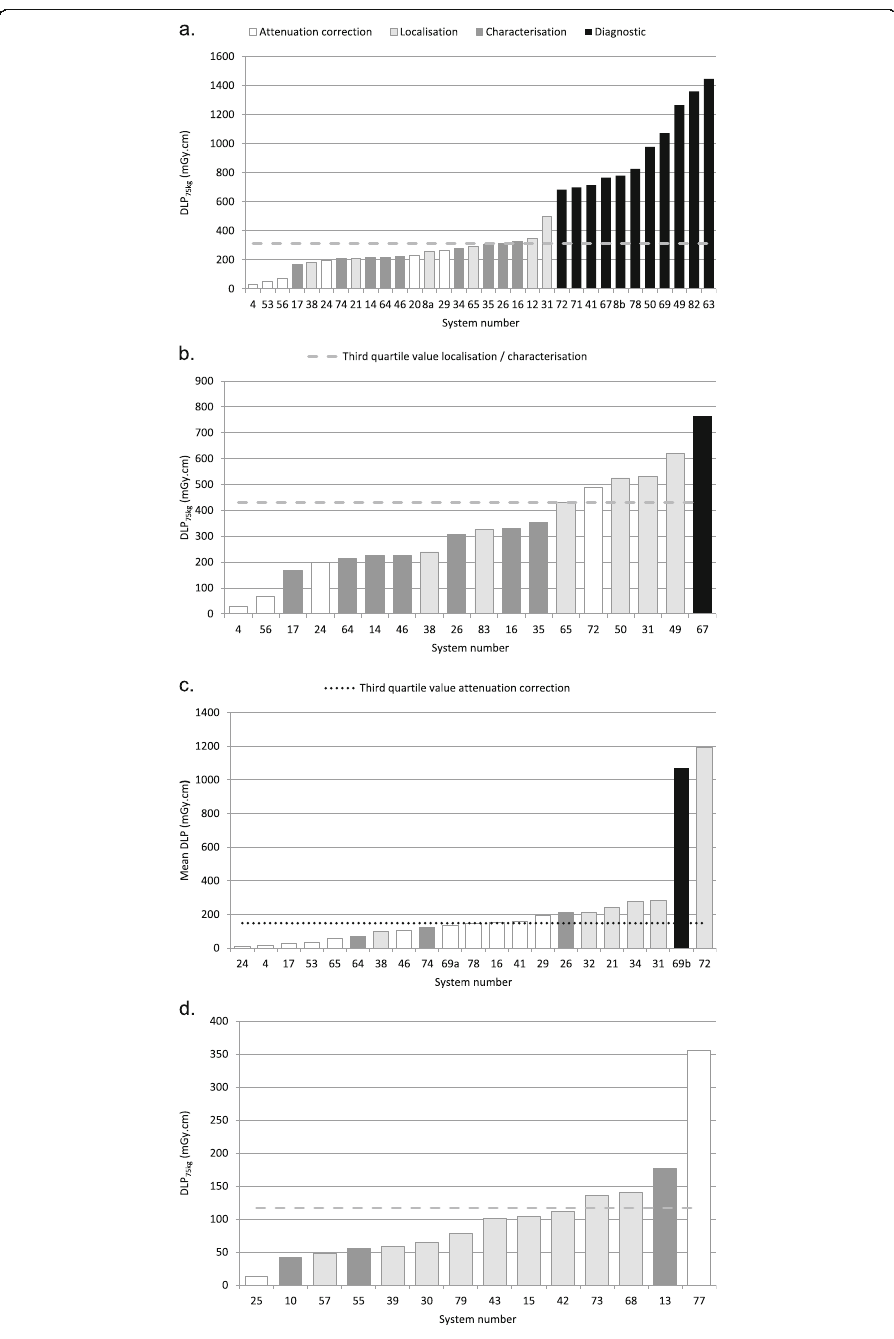
Fig. 2 Distribution of DLP 75kg according to system number and clinical purpose for PET/CT oncology whole body (Data submissions from a system for more than one clinical purpose are labelled with a letter suffix) ( a ), PET/CT infection/inflammation ( b ), PET/CT brain (Mean DLP data (not weight-derived) normalised to a 16-cm CTDI phantom are given for PET/CT brain; Data submissions from a system for more than one clinical purpose are labelled with a letter suffix) ( c ). SPECT/CT lung ( d